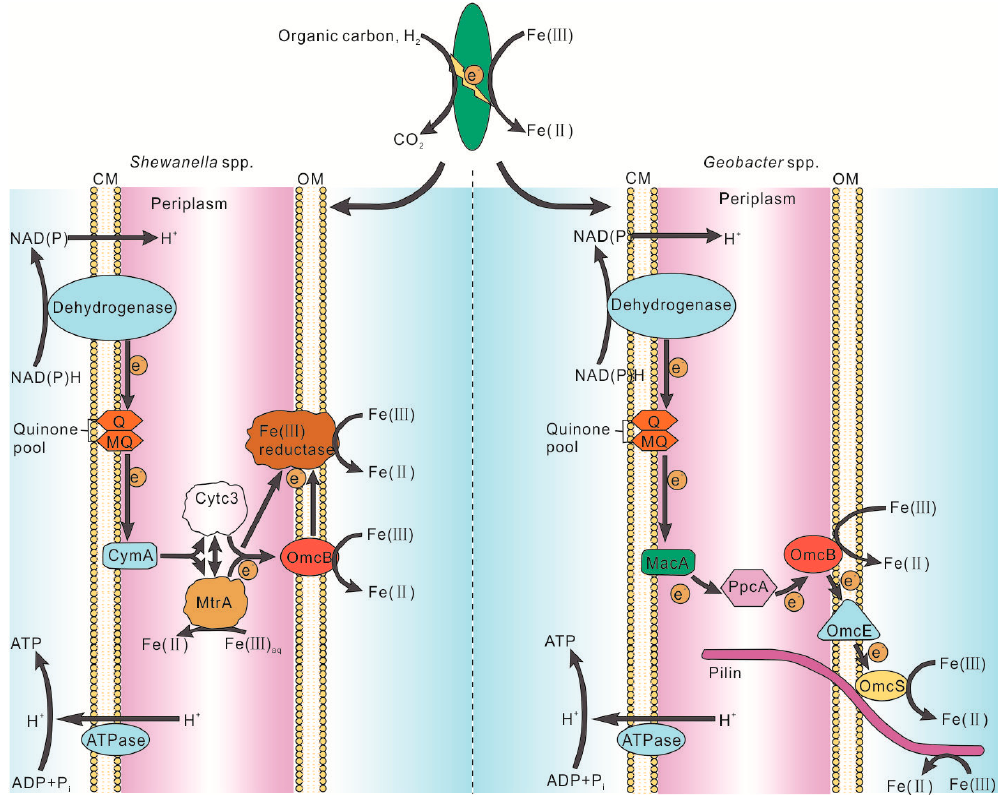
Figure 3. Physiological model of the biochemistry involved in microbial Fe(III) reduction by Shewanella and Geobacter spp. [5].